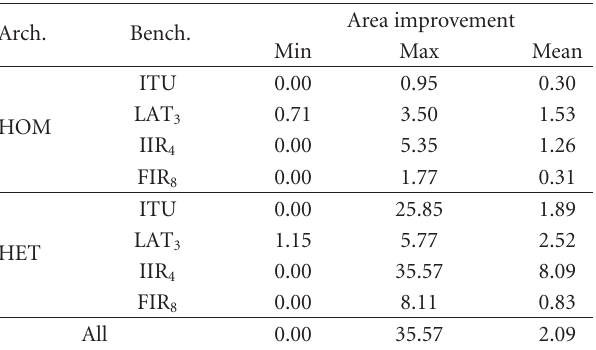
Table 6: Complete versus simplified cost estimation: area improve- ment